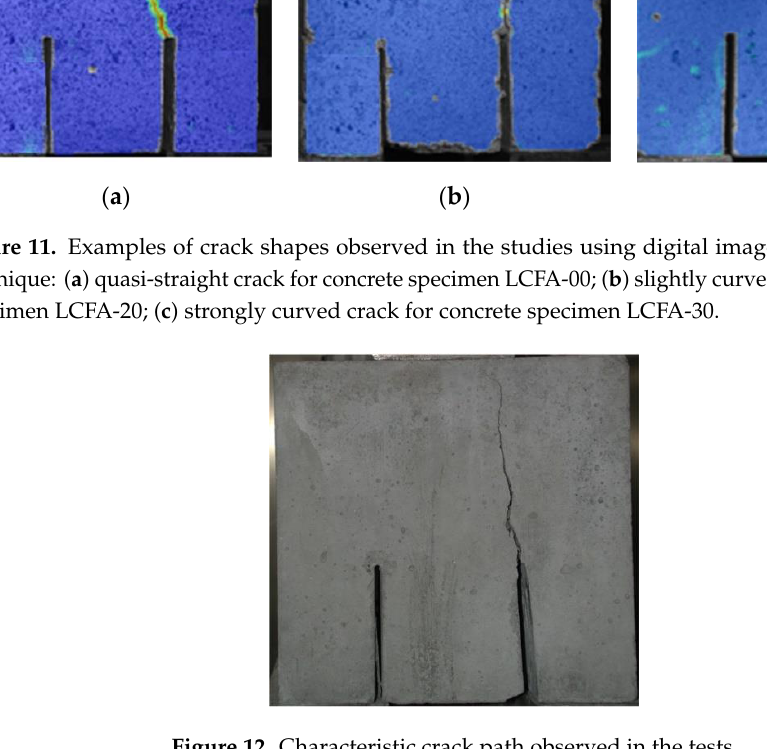
Figure 13. View of cracks occurring on the characteristic planes of the specimen: A–D—description in the text.